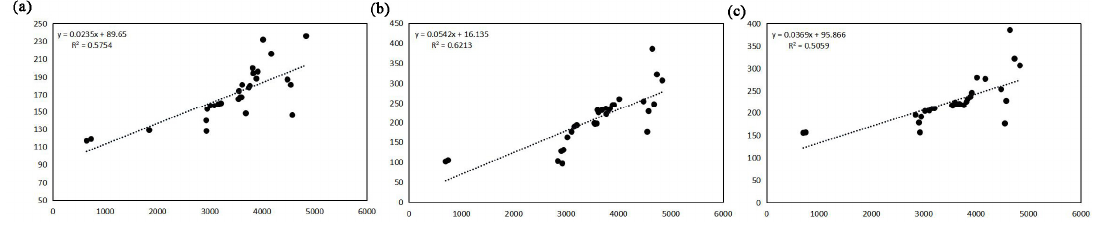
Figure 9. Variation of TDS with altitude of the Yarlung Tsangpo River during wet, normal and dry periods. The dotted line represents the fitting line. The black dots represent the sampling points.